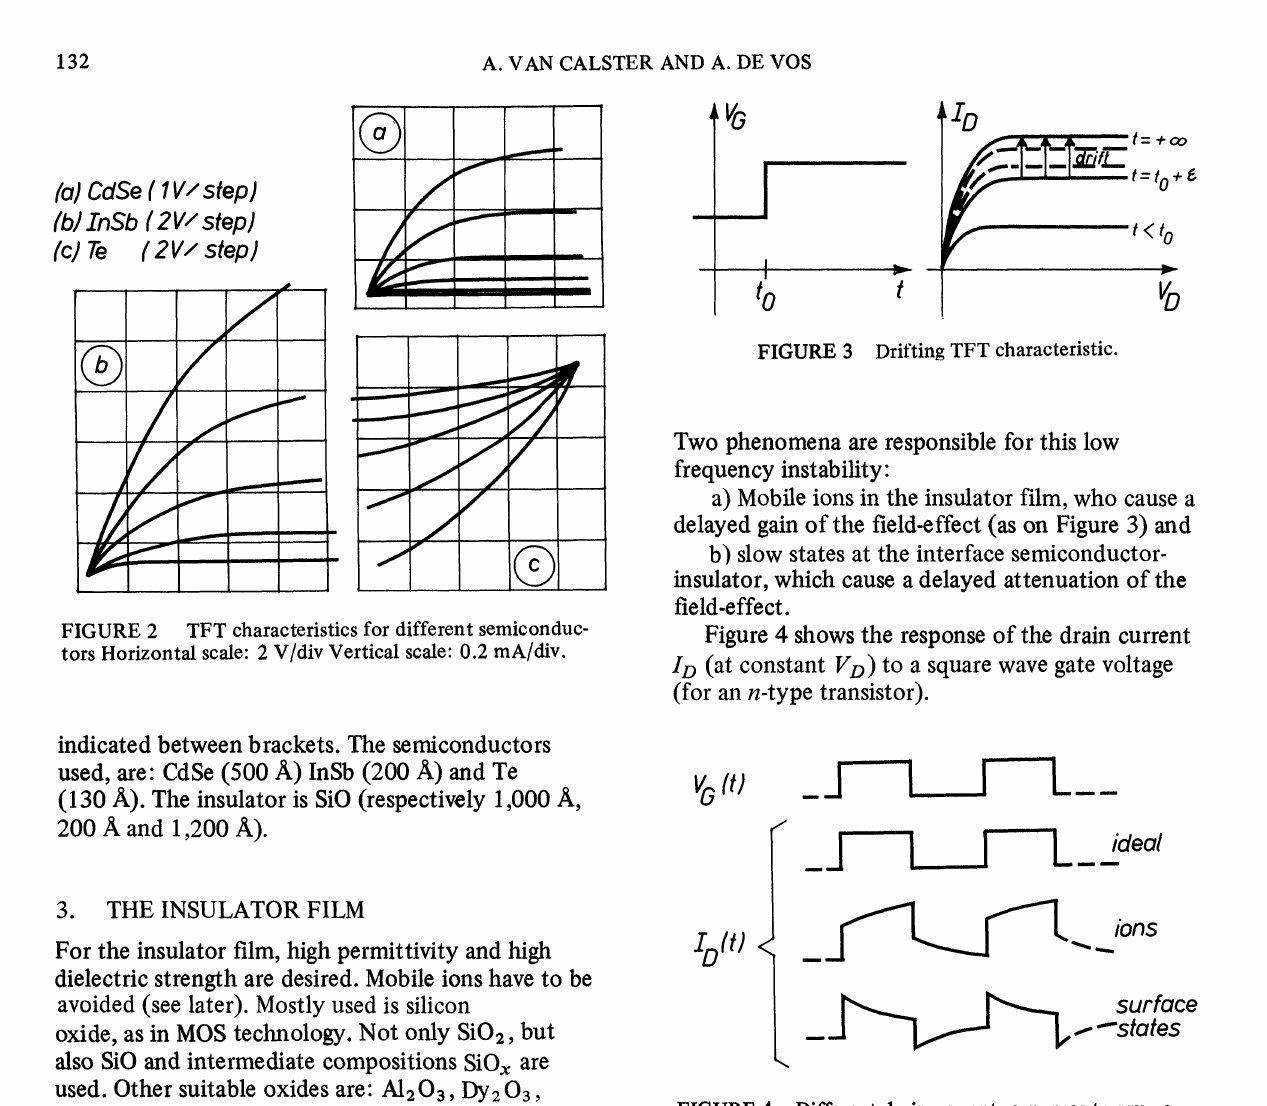
FIGURE 4 Different drain current responses to square wave gate